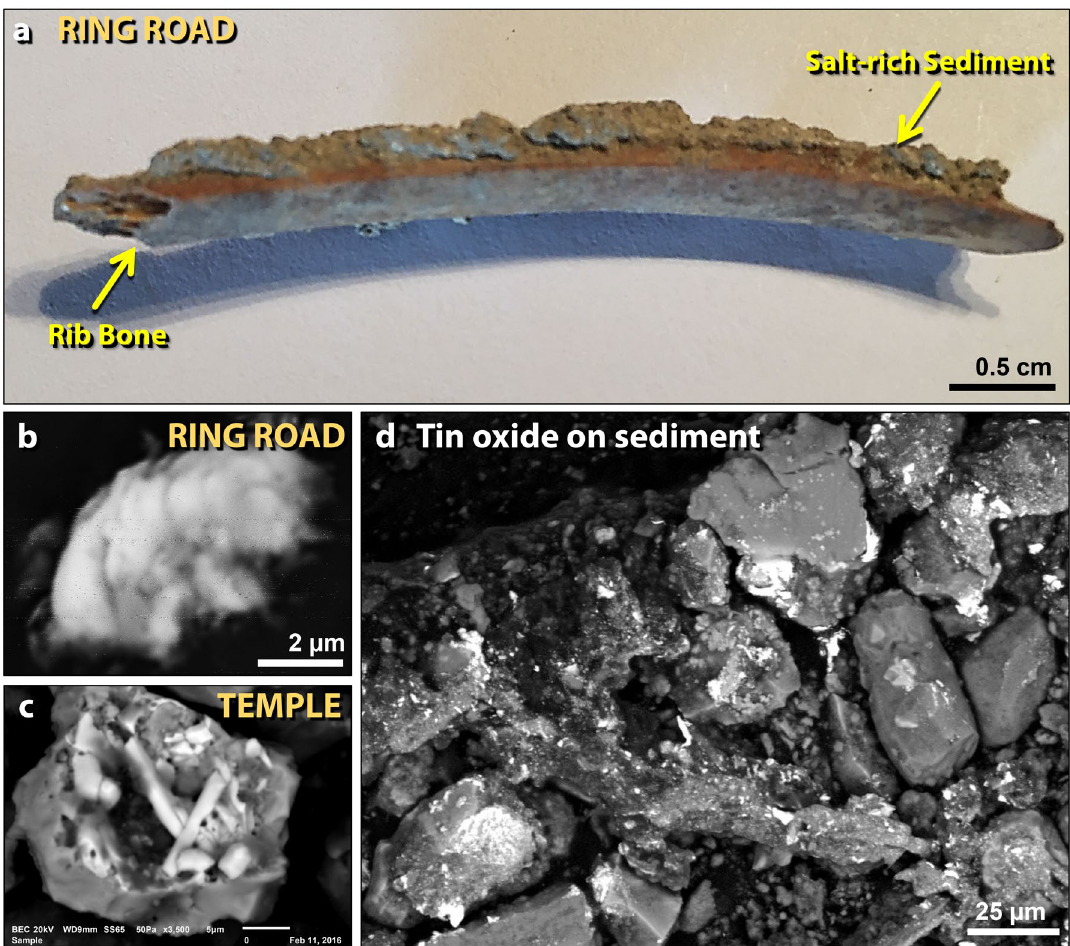
Figure 46. Bone associated with salt and melted tin oxide (SnO 2 ). ( a ) Photomicrograph of 4.7-cm-long human or mammal rib bone from the ring road on the lower tall. NaCl is present at high concentrations in the sediment (~ 54 wt.%) and on the bone (~ 46 wt.%). ( b ) Tin oxide particle (SnO 2 ) appears to have collided with sediment on the bone while it was molten, possibly as unoxidized tin. The melting point of SnO 2 is ~ 1630 °C, but unoxidized tin melts at ~ 232 °C. ( c ) A similar tin oxide particle from the temple, ~ 150 m away from the lower ring road sampling site. Particles are fused into meltglass. ( d ) Tin oxide splashed onto sediment around the bone in panel ‘ a